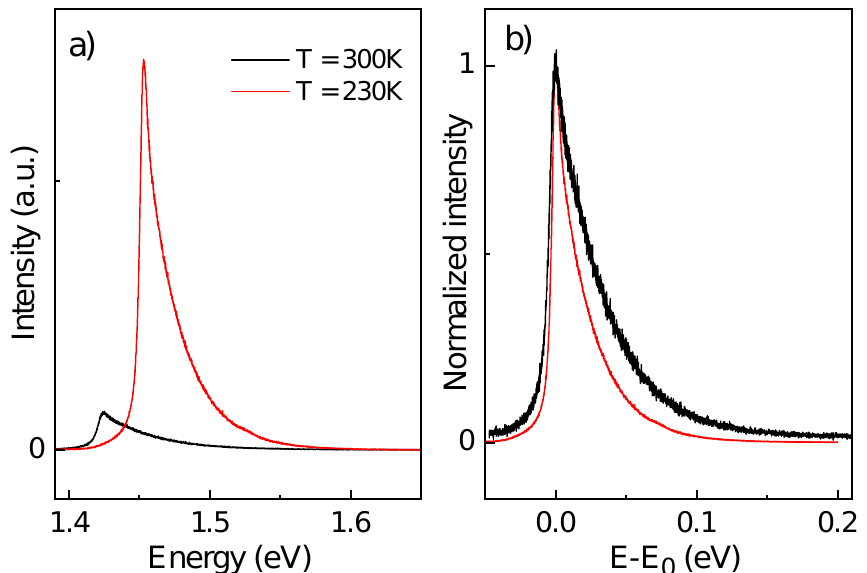
Figure 3. ( a ) PL data from a GaAs wafer taken with a green laser (532 nm) at T = 300K (black) and T = 230K (red). ( b ) Normalized GaAs PL intensity as a function of the difference between emitted energy and GaAs band-gap